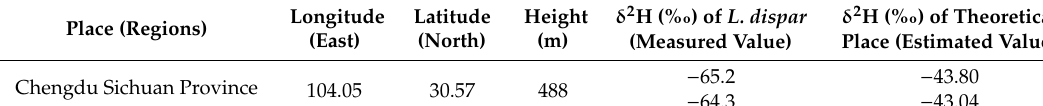
Table 4. L. dispar model validation.